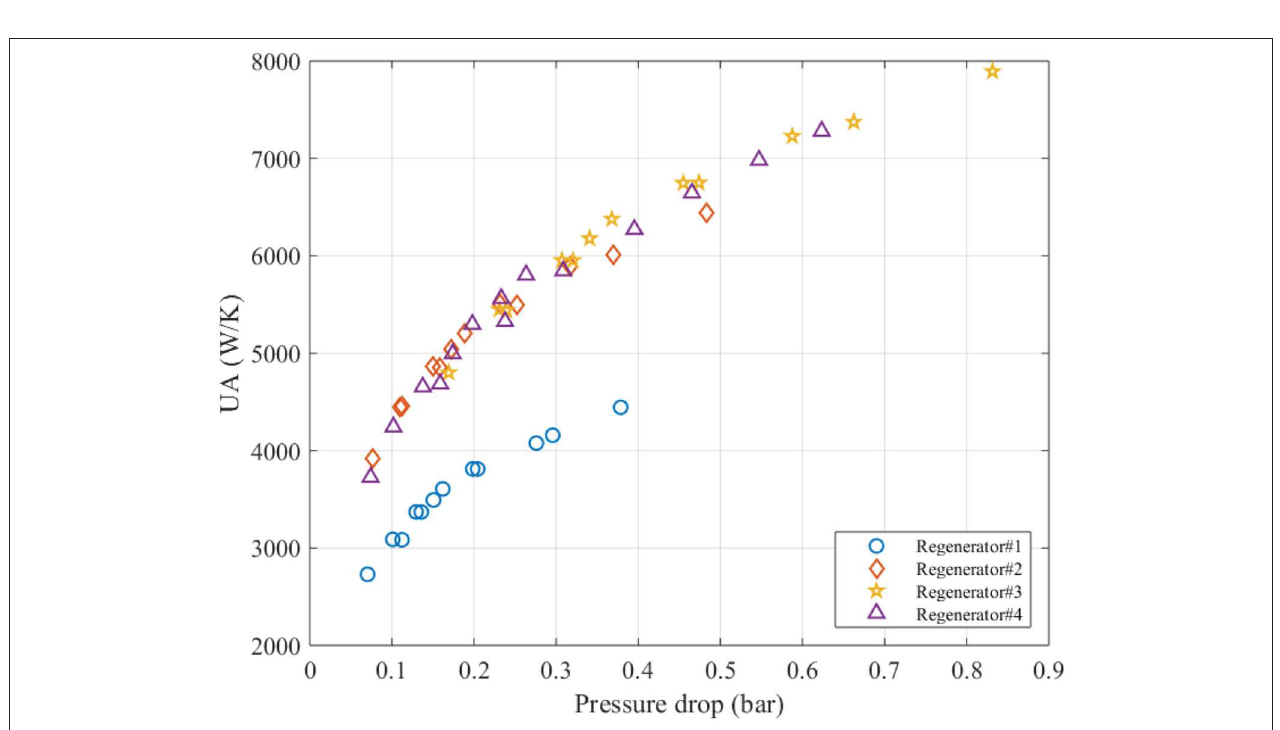
FIGURE 7 | UA vs. pressure drop among regenerators #1, #2, #3 and #4.